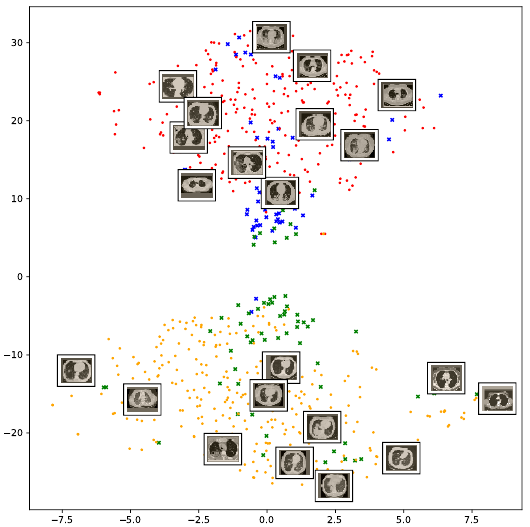
Figure 12. Visualization of the t-SNE embeddings for the entire COVID-19 CT dataset. As in Figure 11, we can see two different clusters representing COVID-19 and non-COVID-19 classes.